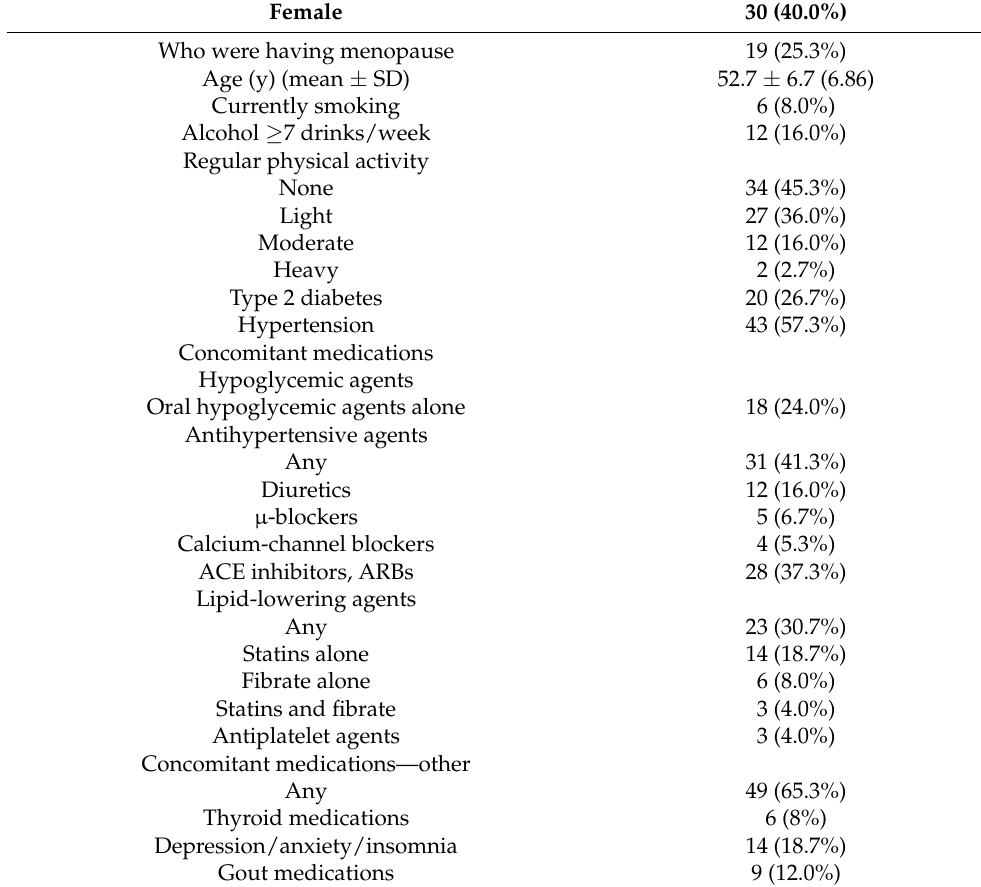
Table 1. General characteristics of the current sample ( n =